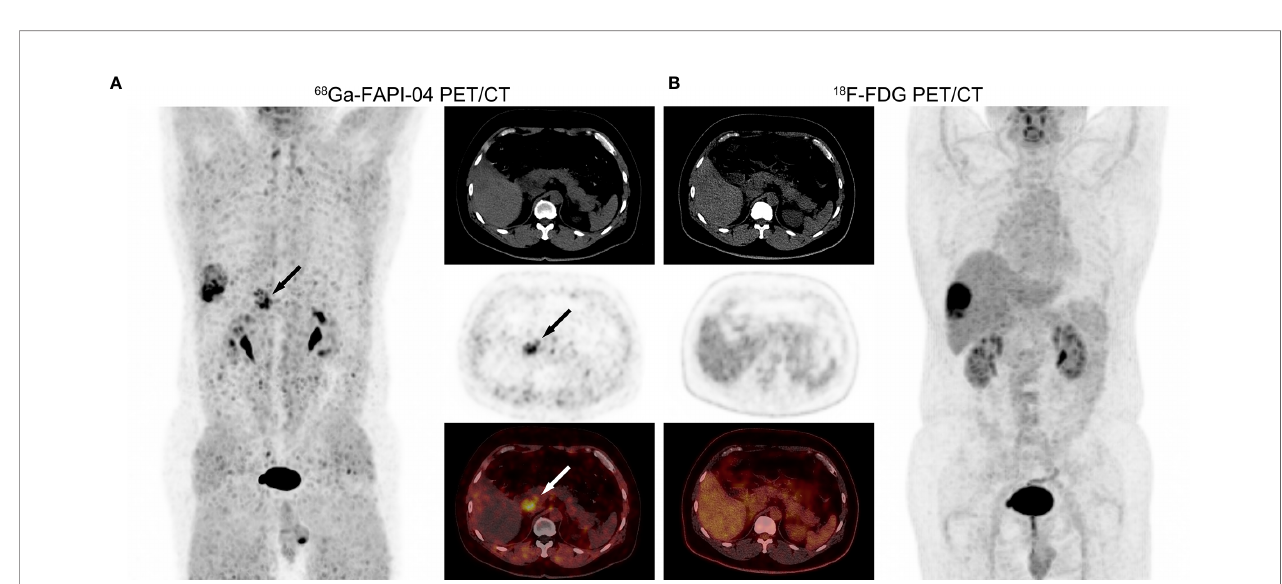
FIGURE 5 | PET/CT images in a 53-year-old male patient with recurrent HCC and extensive peritoneal dissemination. (A) In 68 Ga-FAPI-04 PET/CT, a small metastatic lesion con fi rmed by pathology showed elevated uptake (black and white arrows, SUV max = 4.72, TBR = 11). (B) 18 F-FDG PET/CT did not detect this metastatic lesion (SUV max = 1.27, TBR = 0.63).